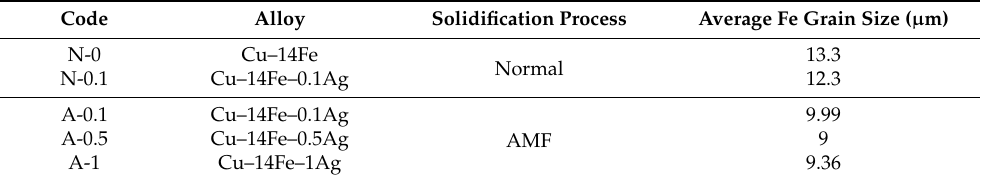
Table 1. Average Fe grain sizes of the various solidification processes. Code Alloy Solidification